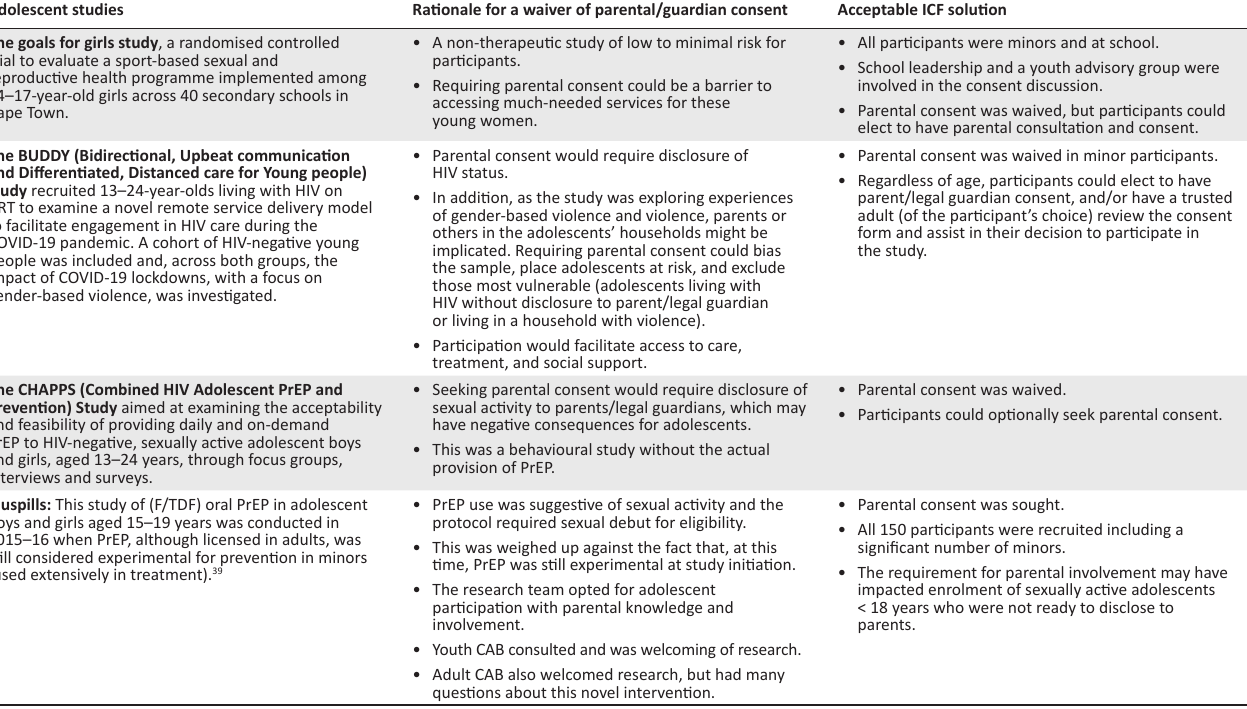
TABLE 1: Examples of adolescent studies undertaken at the Desmond Tutu HIV Centre, together with the rationale for a waiver of parental consent. Adolescent